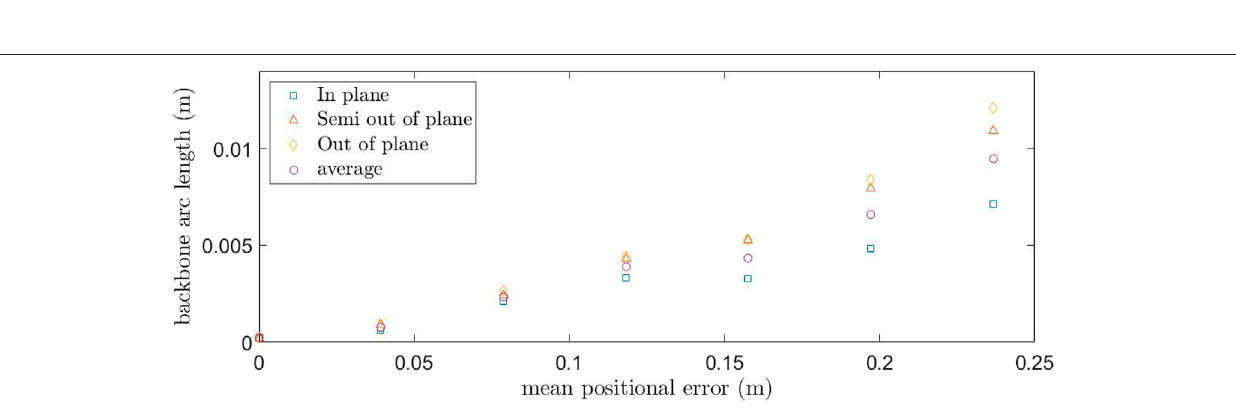
FIGURE 10 | Mean positional error between the OptiTrack observations and model predictions for the three tension groups. The average result is included for overall comparison.